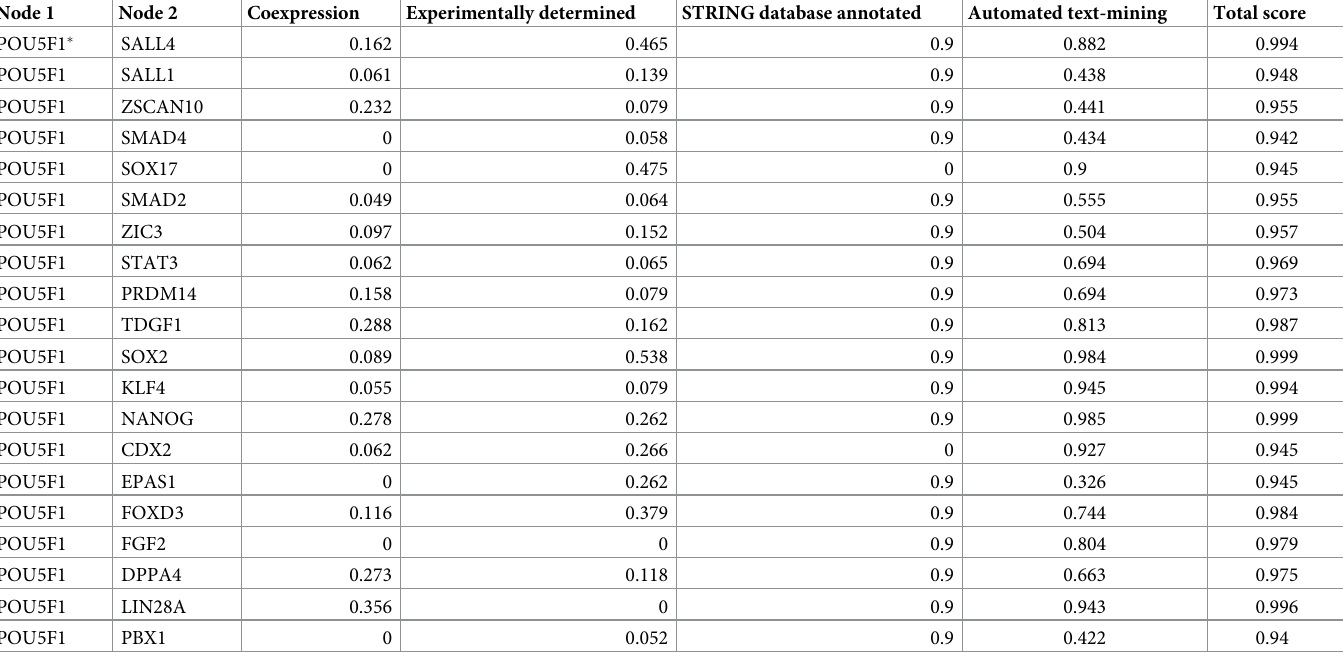
Table 1. Tabulated representation of interacting network of Oct4 with other important proteins from STRING database. Node